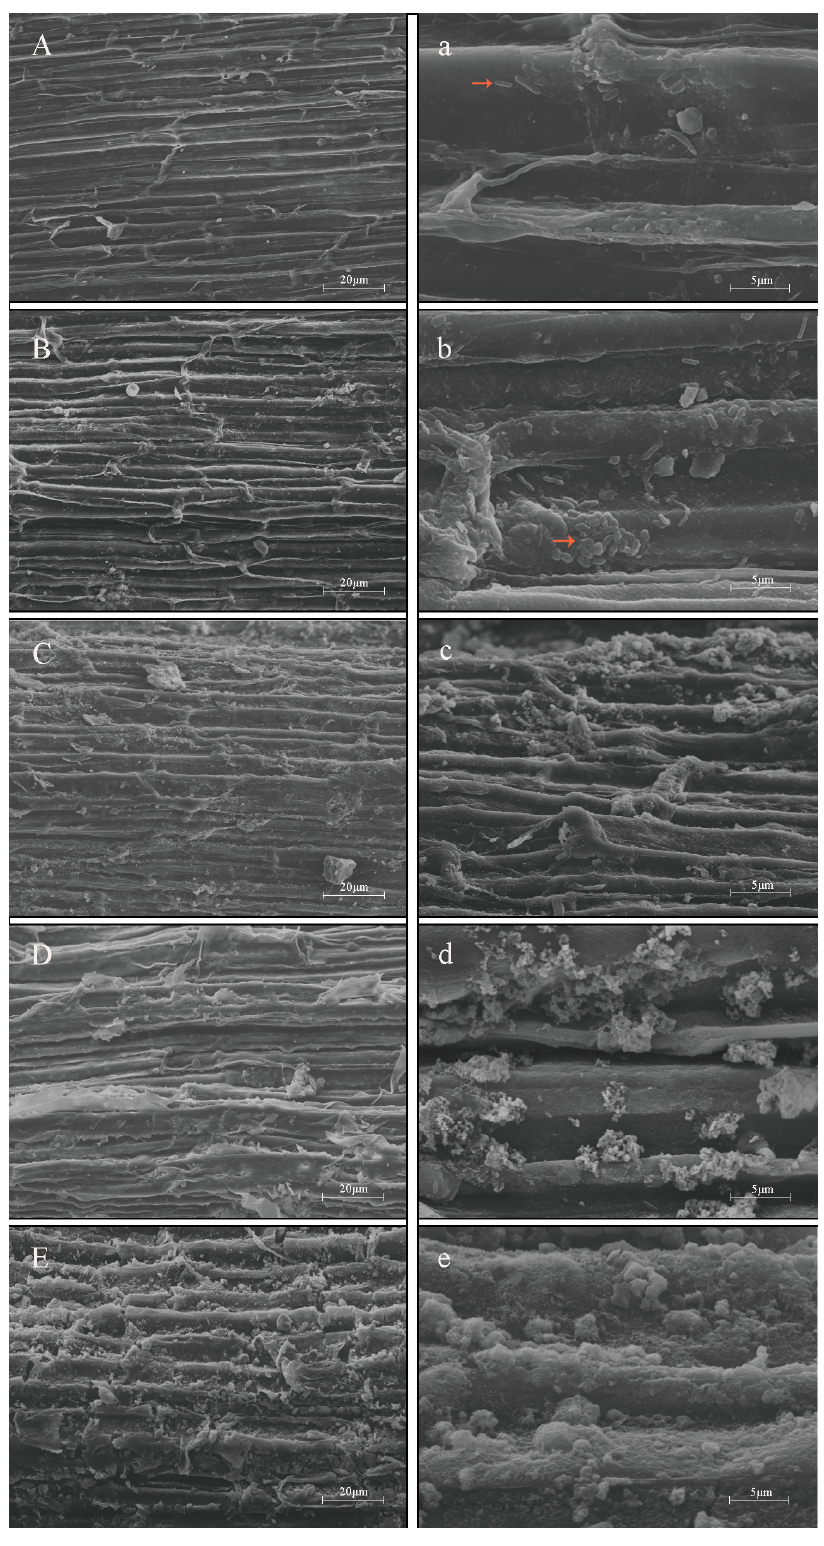
Figure 2. Different amounts of iron plaque formed on the roots of G. spiculosa observed by Scanning Electron Microscopy (SEM), accuracy of 20 μ m: ( A – E ), accuracy of 40 μ m: ( a – e ). Five treatments were represented: Fe 0/P 0.1, Fe 1/P 0.1, Fe 20/P 0.1, Fe 100/P 0.1, Fe 500/P 0.1. Red arrows indicated microorganisms exsiting on the roots surface.